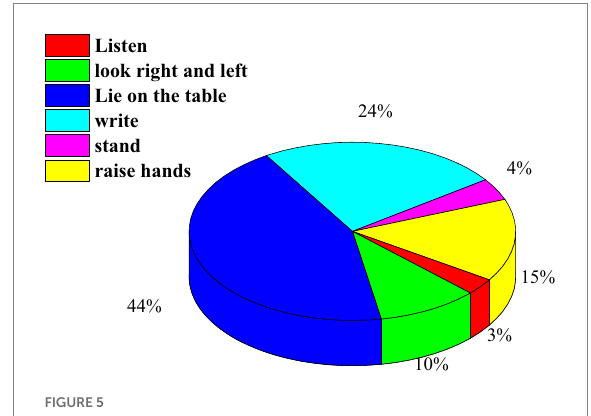
FIGURE 5 Image number distribution of six categories of